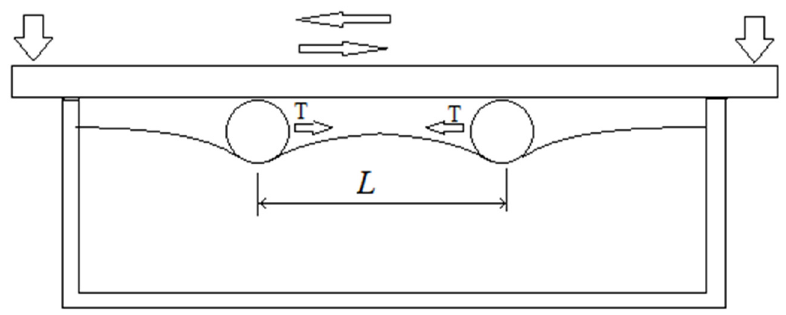
Figure 1. Scheme of the